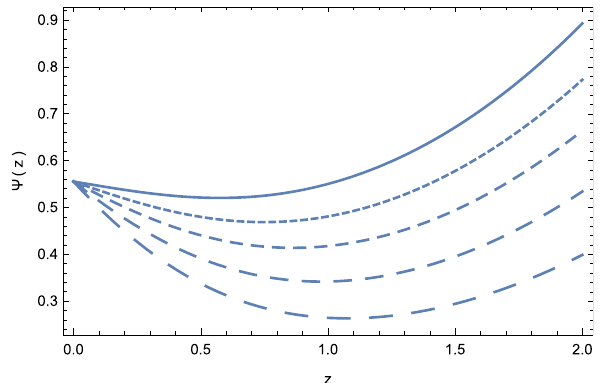
(cid:11) (cid:12) ˜ Q , ˜ T =